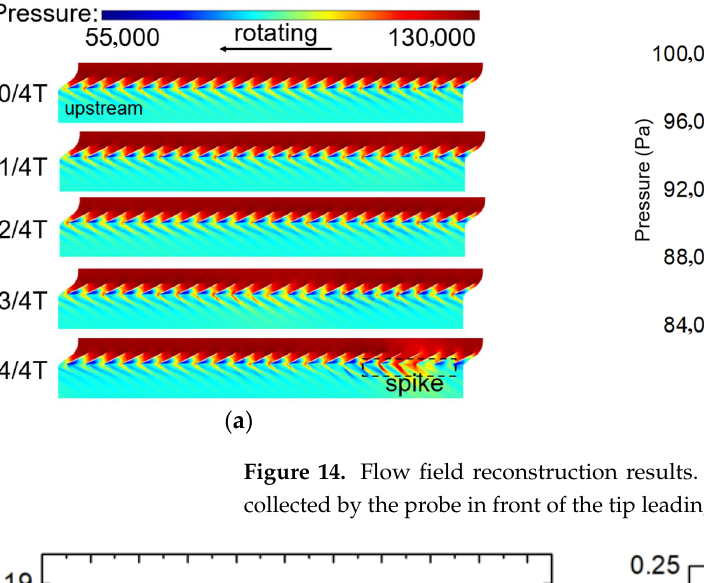
Figure 14. Flow field reconstruction results. ( a ) Rank11 reconstruction flow field. ( b ) Pressure col- lected by the probe in front of the tip leading edge.